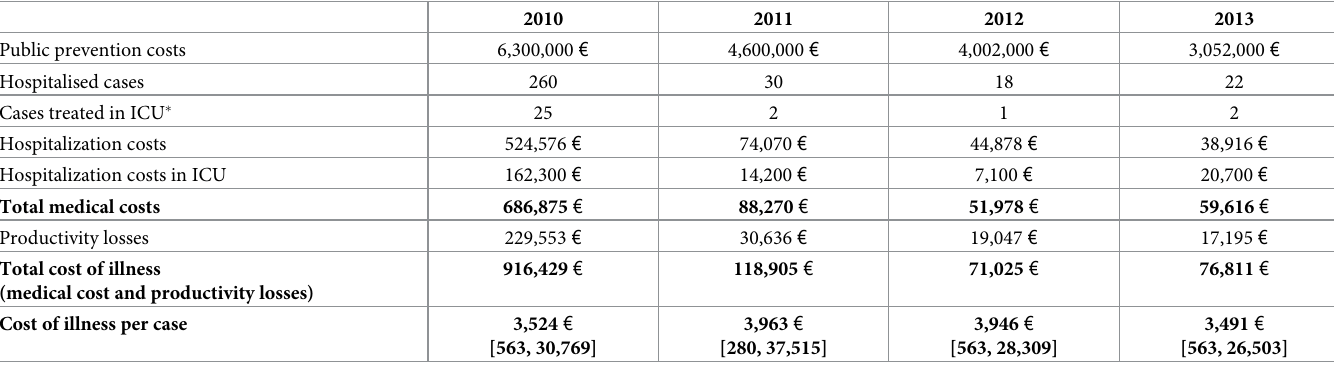
Table 2. Cost of illness for WNV outbreak in Central Macedonia